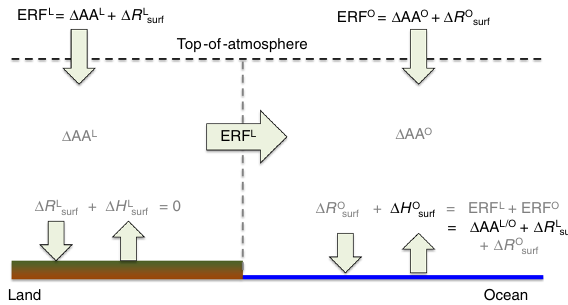
Fig. 4 Energy balance constraints on surface heat fl ux patterns. The top-of- atmosphere (TOA) effective radiative forcings (ERF) over land and ocean (ERF L/O ) must equal the surface radiative perturbation ( Δ R L/O surf ) plus any atmospheric absorption ( Δ AA L/O ) by vertical radiative energy conservation. Because the atmosphere and land surface cannot store energy long-term ( R L surf + H L surf = 0, assuming positive downward sign convention), the TOA ERFs must be balanced through the ocean surface energy perturbation ( R O surf + H O surf ). The ocean heat fl ux perturbation ( H O surf ) will, therefore, be responsible for balancing the total atmospheric absorption change plus the land surface radiative